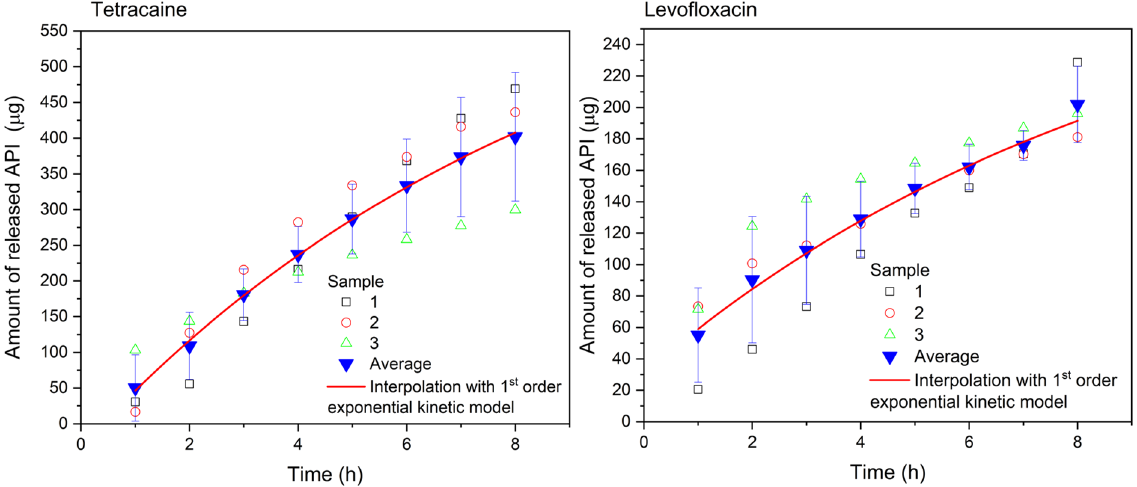
Figure 6. Tetracaine ( left ) and Levofloxacin ( right ) release profile. A loaded collagen drug carrier was placed on the top of the porcine cornea. The number of samples was 3 for each measurement. The release profiles obtained differ from the release profiles recorded for the sole drug carriers. Very flat curves corresponding to the pseudo-first-order release kinetics are observed, which testifies to the transport of a significant portion of the APIs to the cornea, whereas only a part of the APIs is released to the tear-simulating liquid. The mathematical interpolation of the pseudo-first-order model was done for both APIs according to Equation (1). The mathematical model agrees well with the experimental data (R 2 = 0.99869 for Tetracaine, and R 2 = 0.98804 for Levofloxacin). Individual increments of the released drug per hour